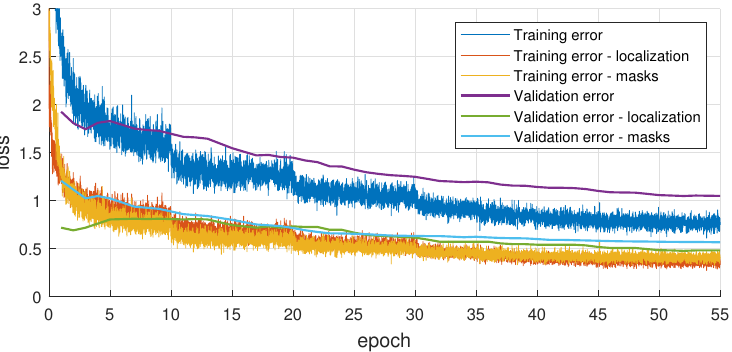
Figure 8. SOLACT model